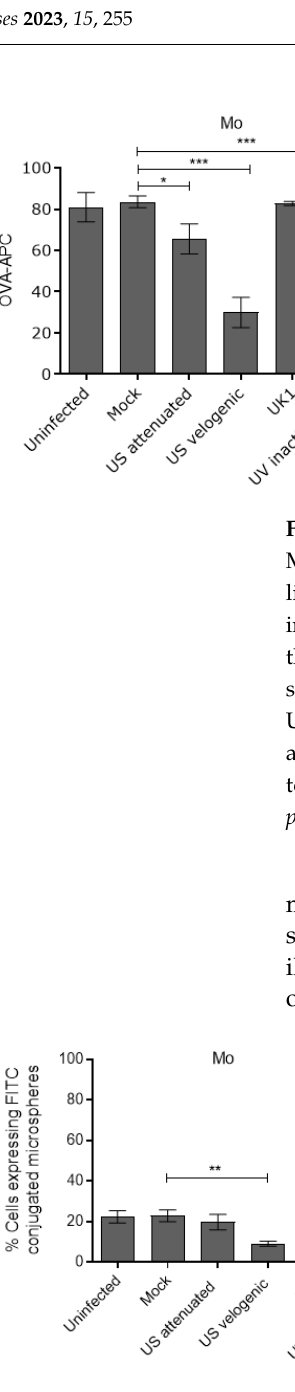
Figure 9. The capacity of EAV infected equine Mo and MoDC to phagocytose antigen. Mo, immature MoDC (iMoDC) and mature MoDC (mMoDC) were inoculated at MOI of 5 with different strains of live or UV inactivated EAV. The percentage cells expressing FITC-microspheres represented the difference in values obtained between the 37 °C and 4 °C (control). There were significant differences in the phagocytic capacity of Mo and mMoDC infected with the Velogenic strains ( a , c ). There were no significant differences in the phagocytic capacity of iMoDC infected with different EAV strains ( b ). Results are represented as the percentage positive cells ± SEM ( n = 6). A 1-way ANOVA with Dunn’s post-test was used to compare replicate means. *, ** and *** indicate significant differences between sample means where p < 0.05, 0.01 and 0.001, respectively.